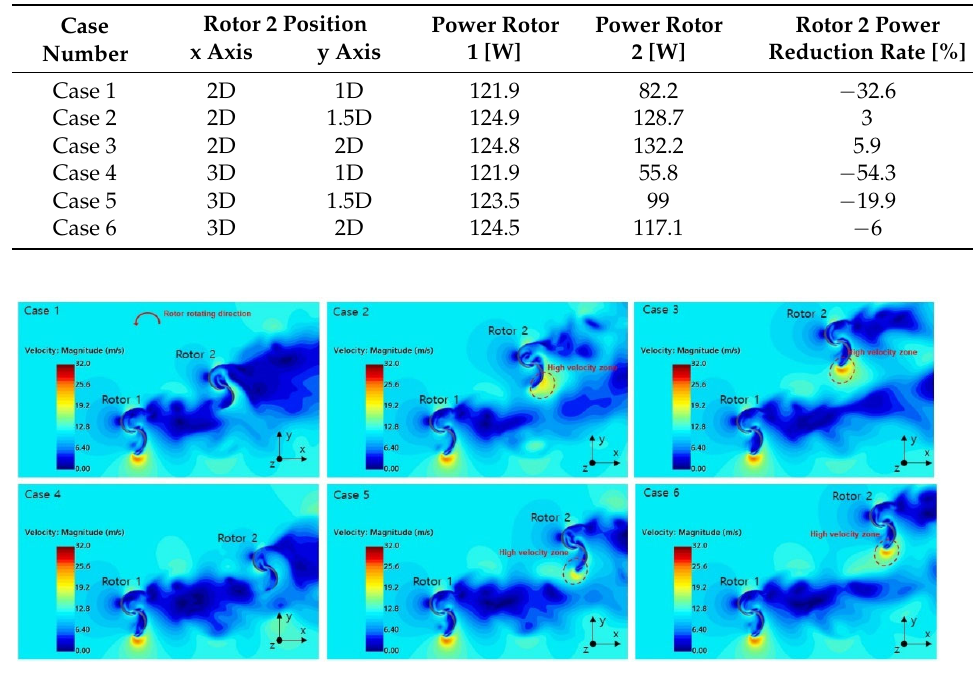
Figure 14. Velocity distribution according to downstream rotor position.